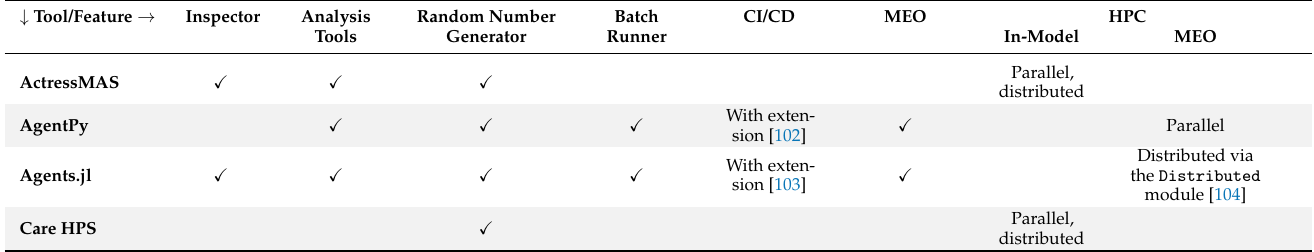
Table 4. Comparison of ABM tools based on their